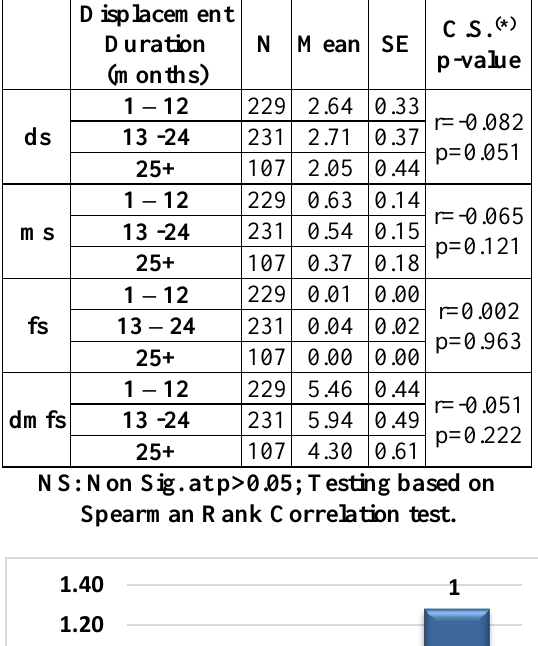
Table 5: Mean and standard error and the correlation of dental caries in deciduous teeth of internally displaced children according to duration of living in camps.